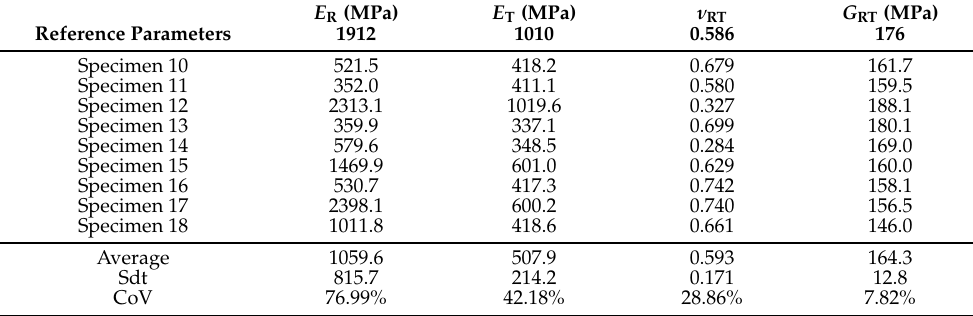
Table 9. Identified orthotropic linear elastic parameters for the off-axis specimens and comparison to the reference values